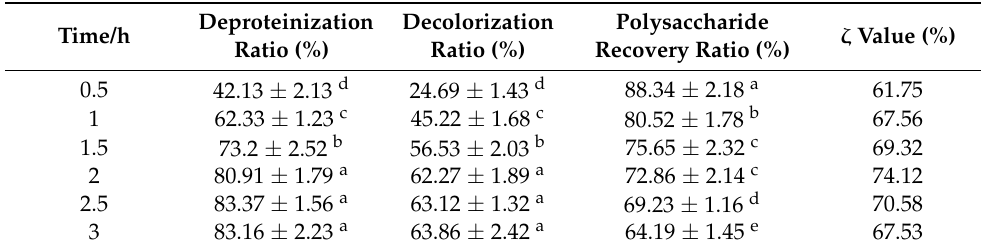
Table 3. Effect of time on decoloration ratio, deproteinization ratio, polysaccharide recovery ratio, and selectivity coefficients of A-722MP